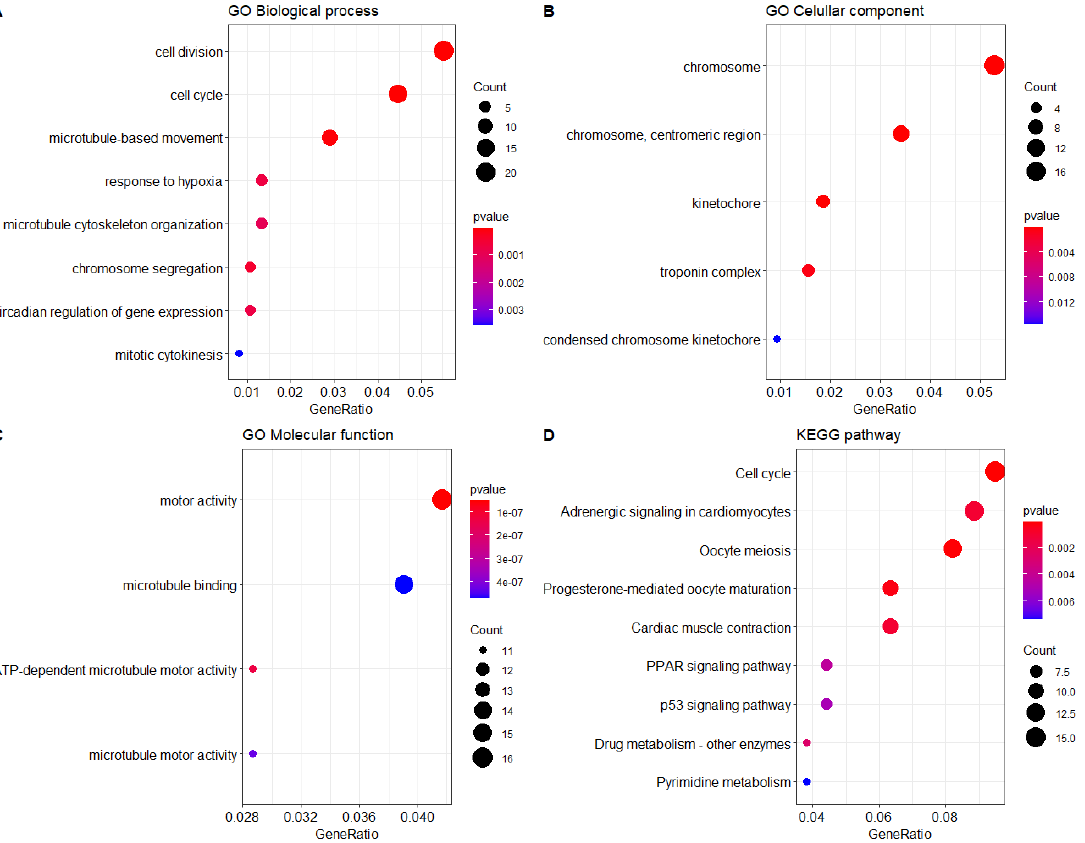
Figure 8. Representative analysis of Gene Ontology (GO) and Kyoto Encyclopedia of Genes and Genomes (KEGG) pathways in skin of yellowtail using DEGs based on comparison between control and silkrose-treated groups. ( A ) Enriched biological process terms from DEGs. ( B ) Cellular component terms enriched in DEGs. ( C ) Enriched molecular function terms from DEGs. ( D ) Molecular pathways enriched by silkrose-containing diet. GO and KEGG enrichment analysis was conducted using clusterProfiler package (v. 3.18.1) [49] in R software. Due to the limited annotation of yellowtail genome, resulting in a low mapping rate, we used a combination of KEGG pathway, GO annotation, and manual literature searches to identify immune-related genes that were differentially expressed, as shown in Table 1. Table 1. List of upregulated immune-related genes (log2 fold-change > 2) and their expression ratio in skin of yellowtail after being fed silkrose-containing diet.